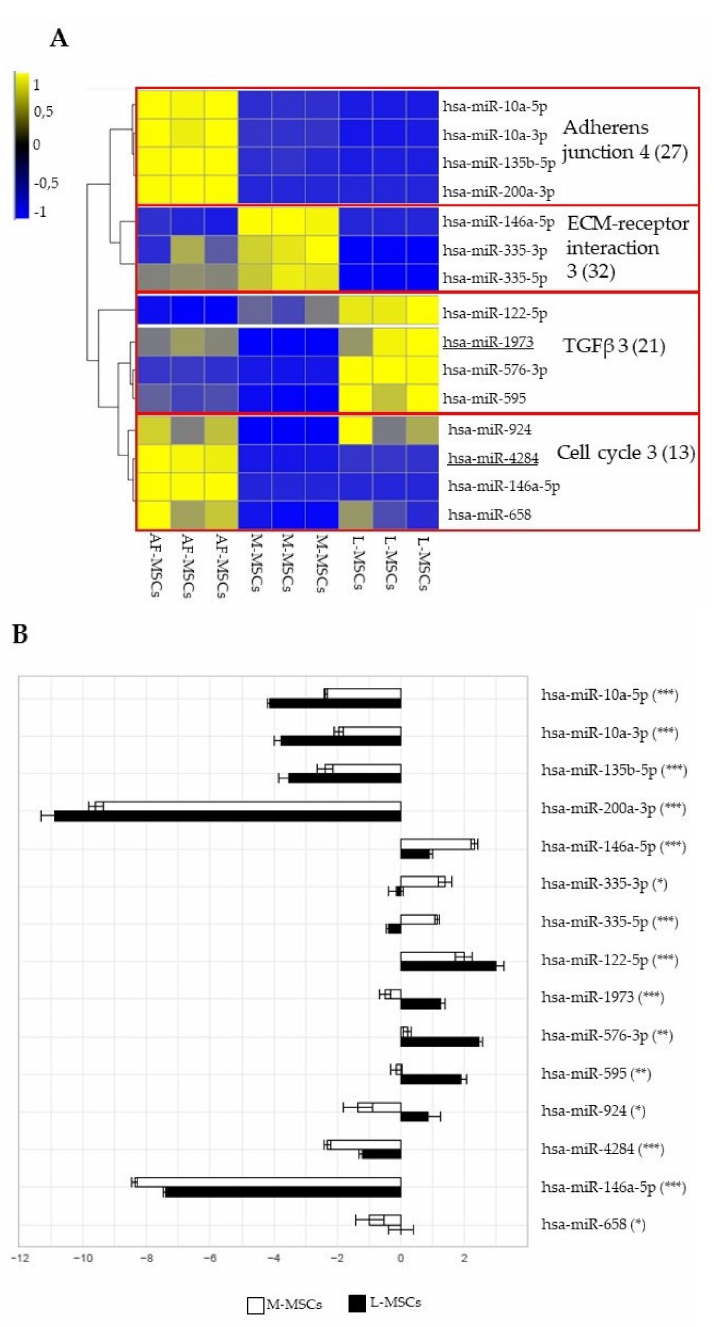
Figure 4. Heat map and expression fold change of 15 miRNAs previously identified as differentially expressed between M-MSCs and L-MSCs based on next generation sequencing analysis. ( A ) Each row represents a different miRNA, and each column represents one sample from the AF-MSCs ( n = 9), M-MSCs ( n = 12) or the L-MSCs ( n = 12) RNA pools. The clusters were obtained by unsupervised hierarchical clustering using Spearman rank correlation and the average linkage method. The key colour illustrates the normalized expression levels (z-scores of normalized counts-cpm) of miRNAs in all samples. The yellow to blue gradient indicates a higher to lower expression. In the right column, the KEGG pathways identified by DIANA-miRPath software as targets of the analysed miRNAs. In brackets, the number of targeted genes per pathways. Underlined miRNAs are not convergent in the indicated KEGG pathway. ( B ) Expression fold changes (log2-transformed) of the 13 selected miRNAs in M-MSCs and L-MSCs as compared to AF-MSCs. Adjusted p value < 0.05: *** both comparisons, ** only L-MSCs, * only